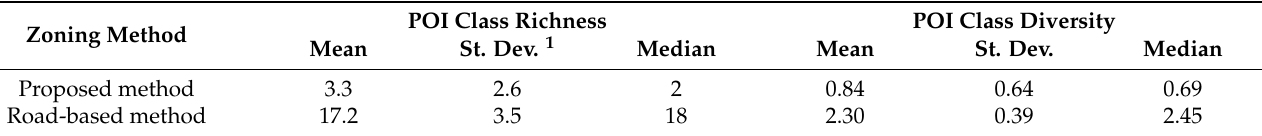
Table 5. Results of richness and diversity indexes measured for two segmentation units.